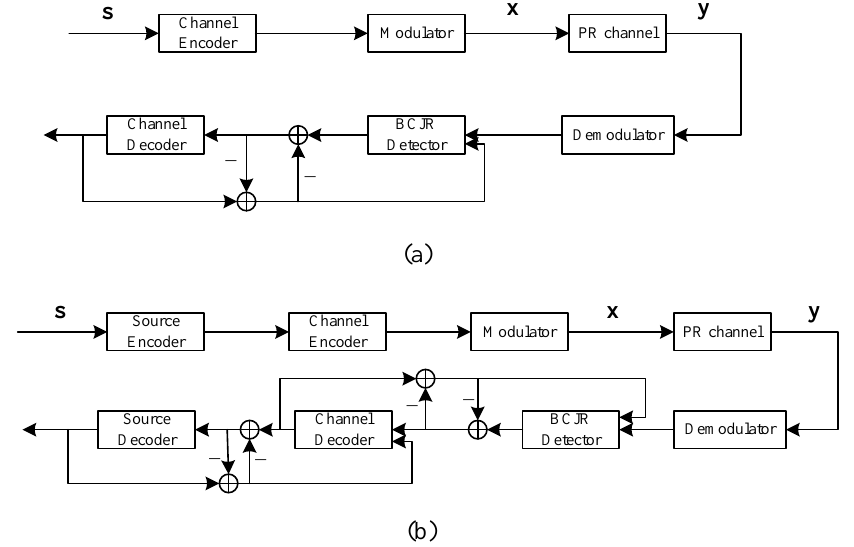
Figure 1. Block diagram of ( a ) the traditional separate channel coding system, ( b ) the proposed system over OD-ISI MR